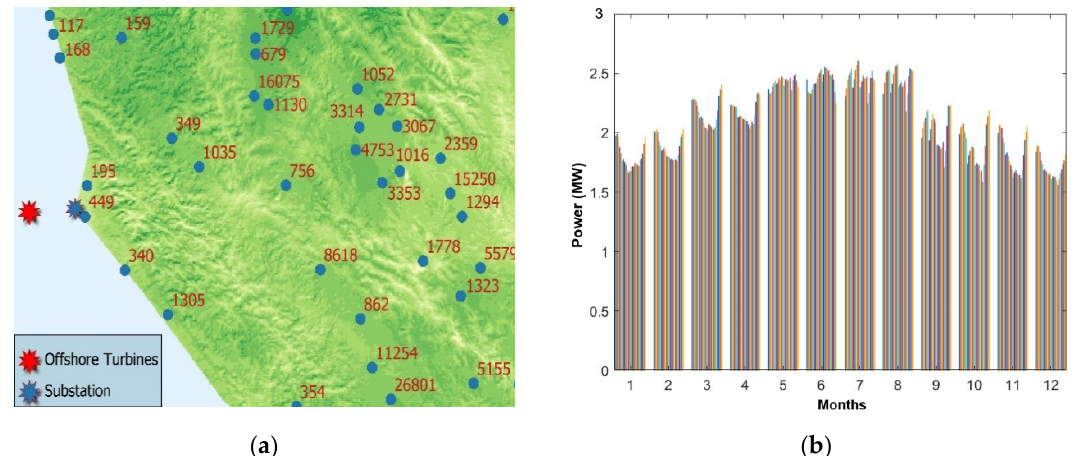
Figure 14. PSPS Cities near the proposed new wind turbines in Point Arena, Northern California. ( a ) Location map; ( b ) average hourly power output per month for one wind turbine. A maximum distance of 165 km was considered for this analysis (from the onshore substation).